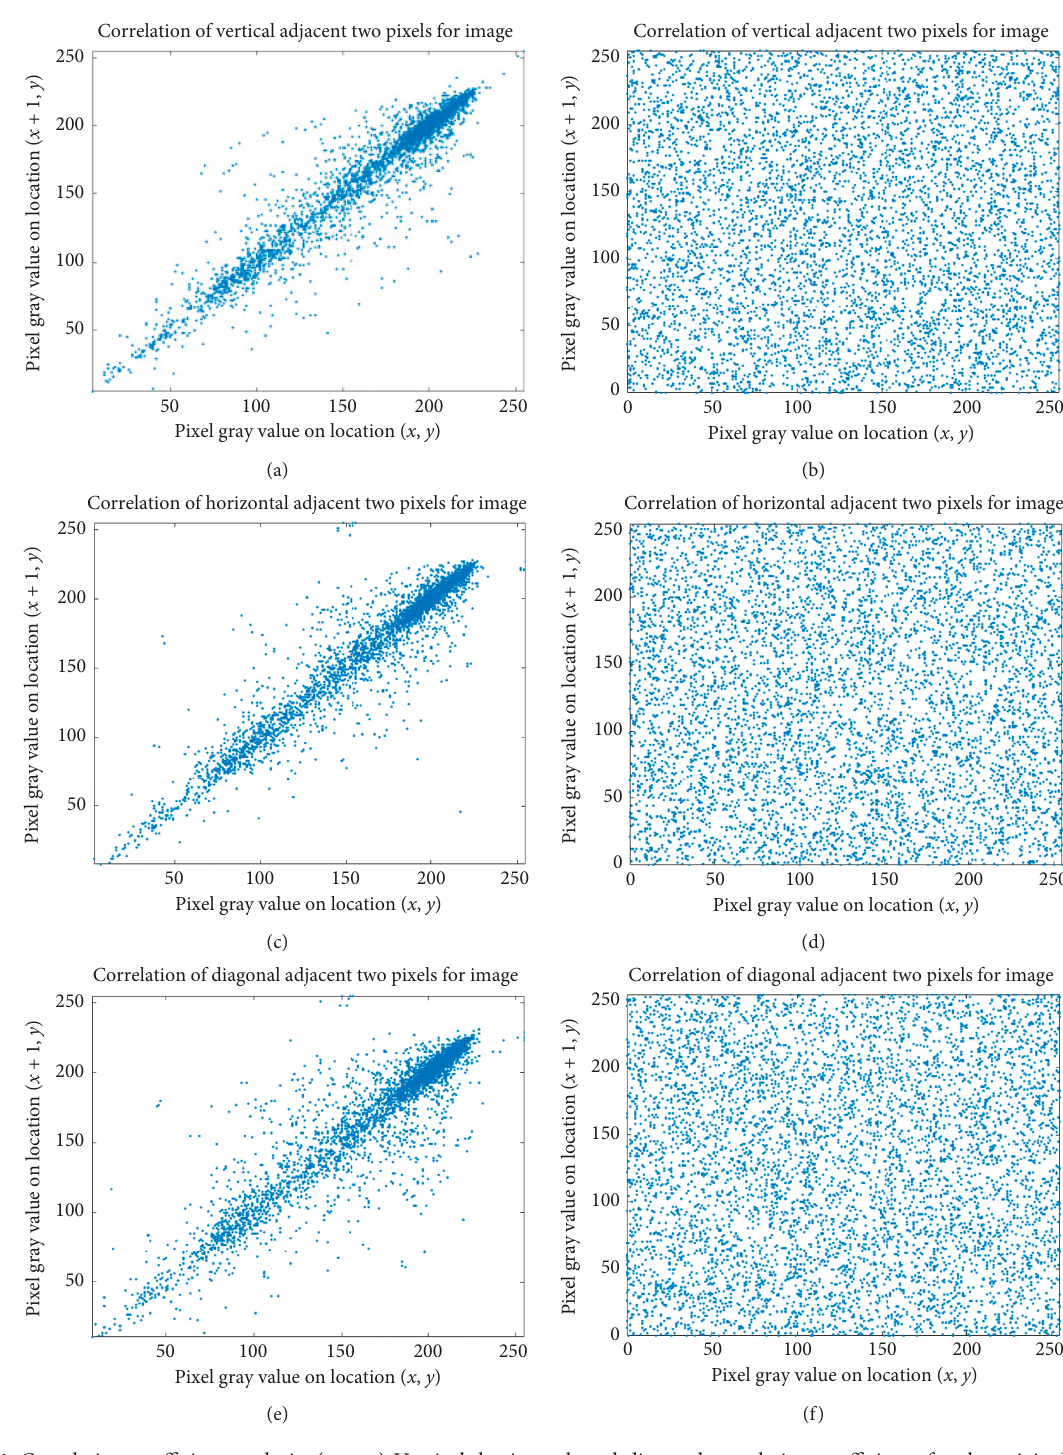
Figure 6: Correlation coefficient analysis. (a, c, e) Vertical, horizontal, and diagonal correlation coefficients for the original image, re- spectively. (b, d, f) Vertical, horizontal, and diagonal correlation coefficients for the encrypted image,